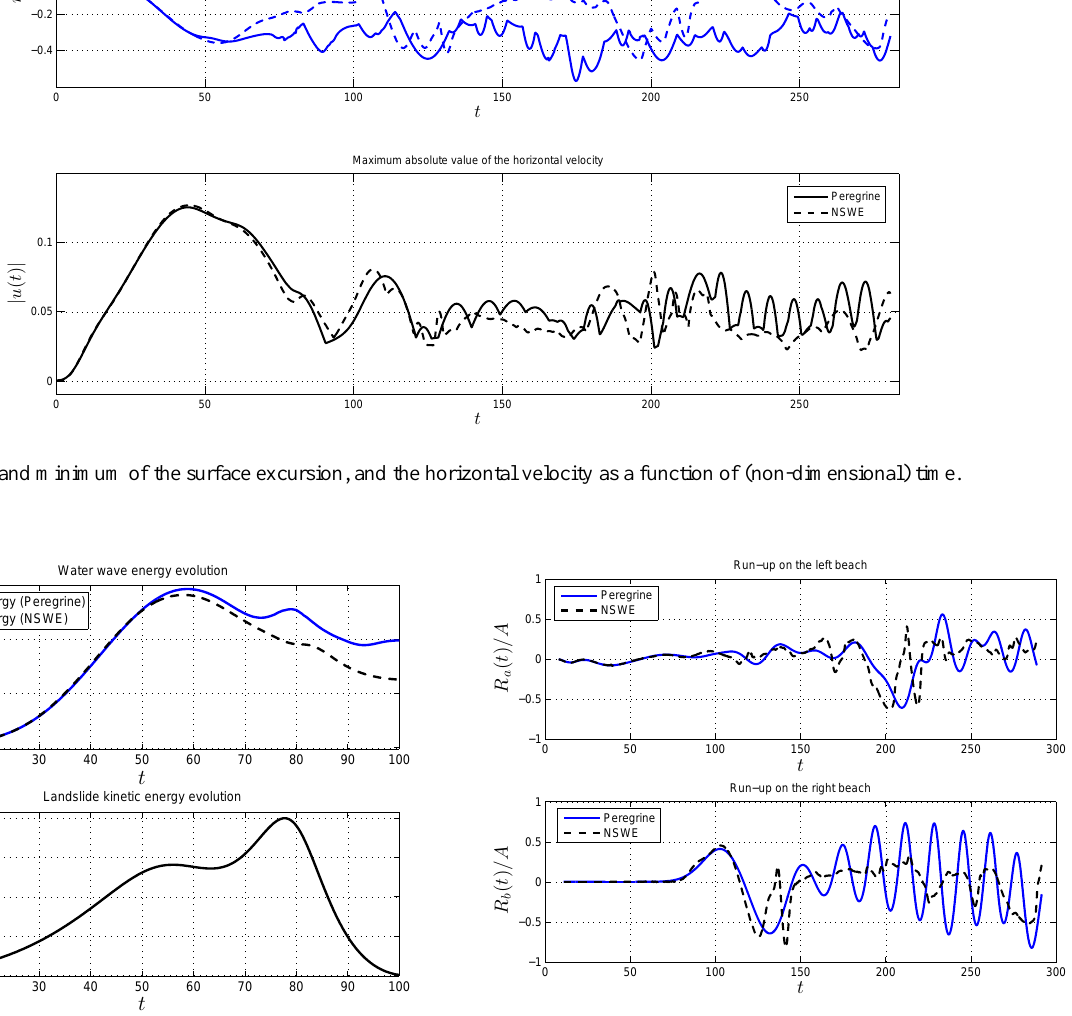
of the landslide.